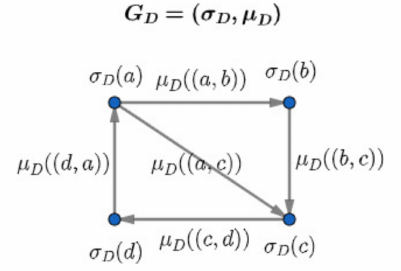
Figure 2. The G D is a fuzzy